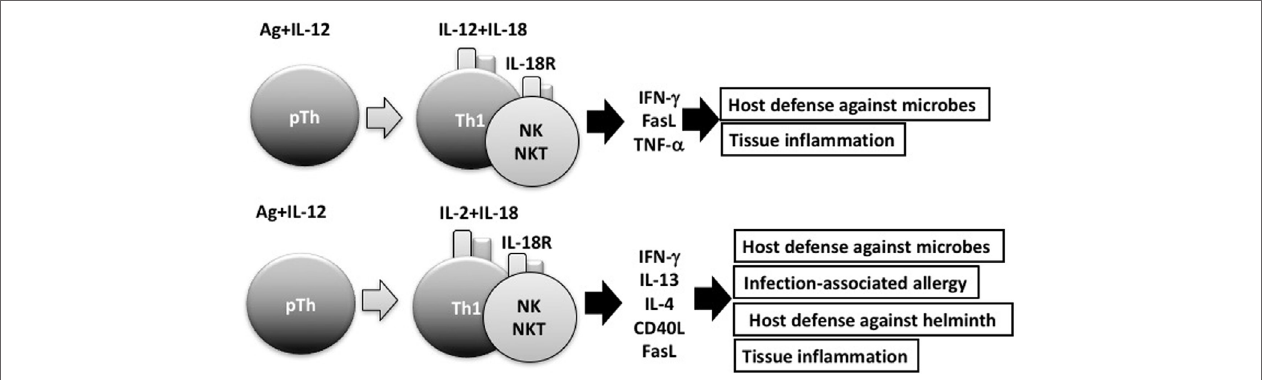
FigURe 2 | Interleukin (IL)-18 facilitates both Th1 response and Th2 response. In combination with IL-12, IL-18 stimulates Th1 cells, natural killer (NK) cells, and NKT cells to produce robust interferon (IFN)- γ , resulting in the clearance of intracellular microbes. However, without IL-12, but with IL-2, IL-18 induces Th1 cells, NK cells, and NKT cells to produce IL-13 and IFN- γ both of which are involved in host defense response or in infection-associated allergy. NKT cells stimulated with IL-2 and IL-18 express CD40L and produce IL-4, thereby inducing B cells to produce